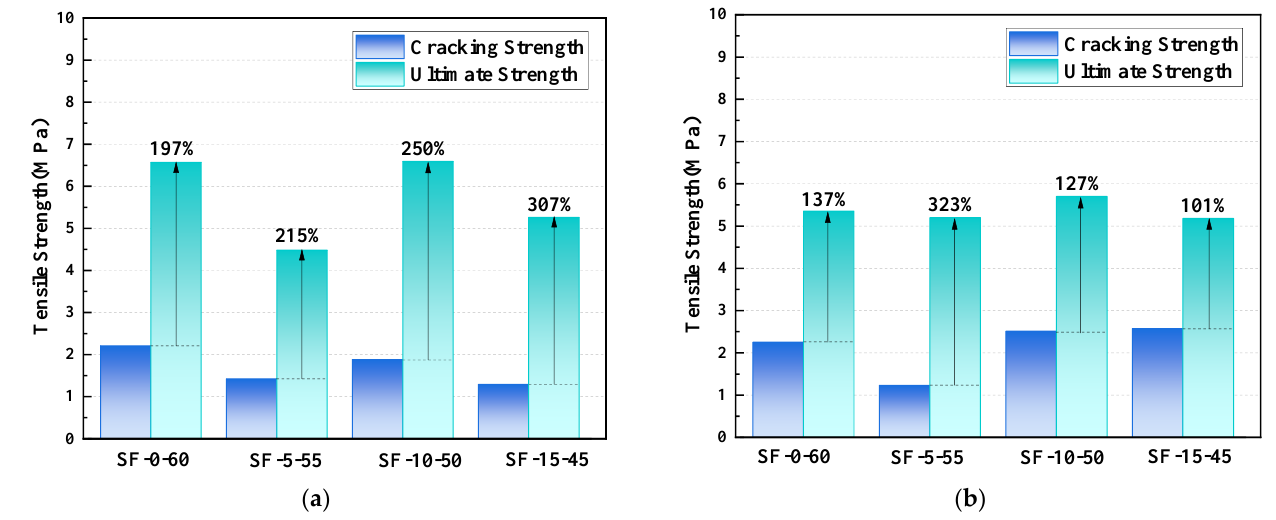
Figure 6. Tensile cracking and ultimate strength of SF-0-60, SF-5-55, SF-10-50, and SF-15-45. ( a ) 7 d curing, ( b ) 28 d curing.